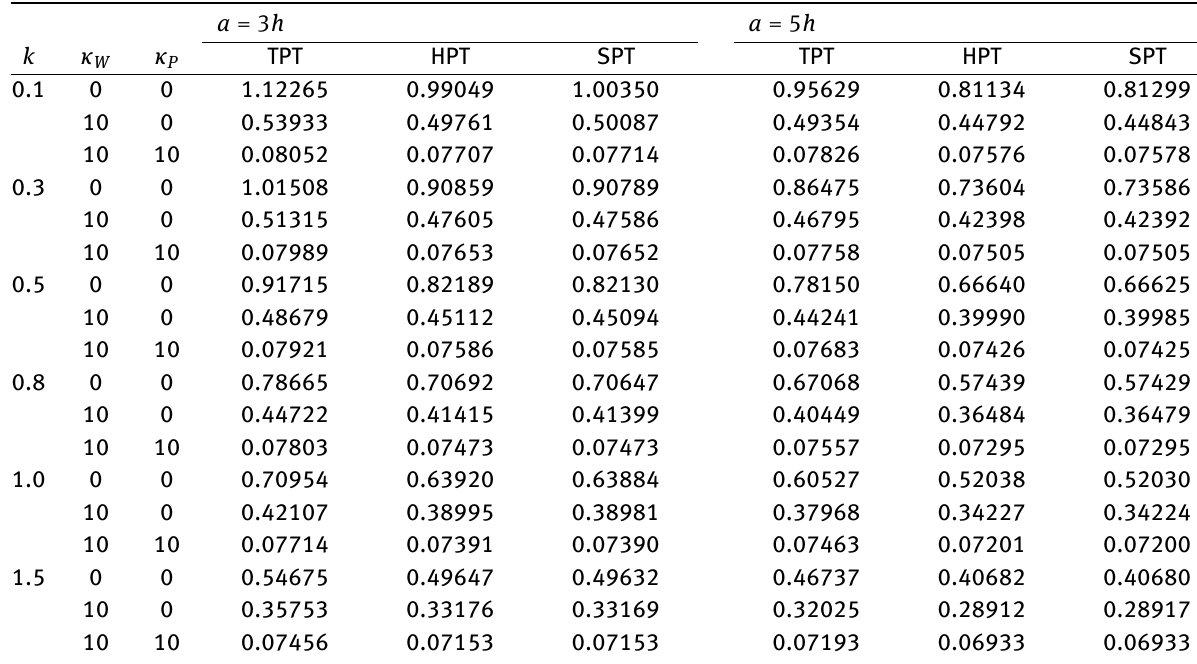
Table 4: Effects of the inhomogeneity parameter k and side-to-thickness ratio a / h on the deflection w (0.5 a , 0.5 b , 0) of the EG thick rectan- gular plate resting on elastic foundations.